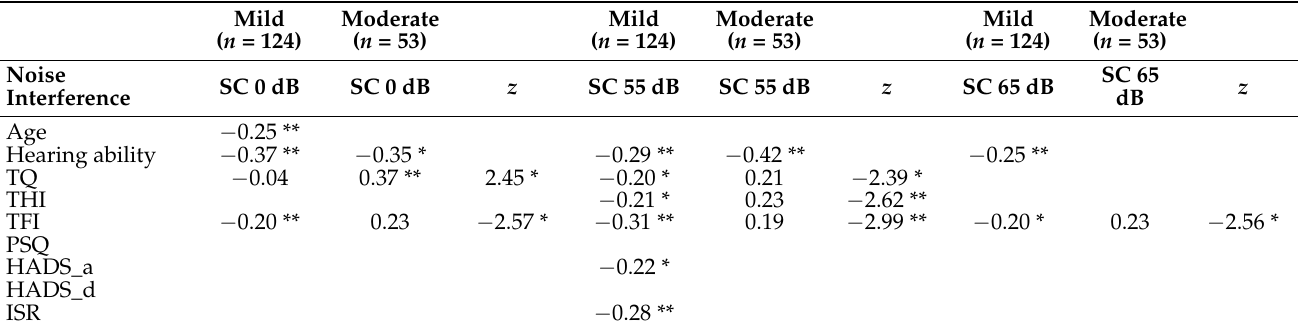
Table 3. Pearson’s r correlation coefficients for baseline values and SC across three noise interfer- ence conditions for patients with mild vs. moderate hearing loss. SC = speech